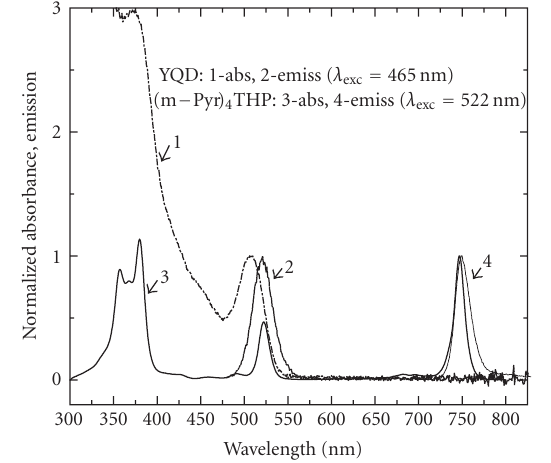
Figure 2: PL quenching of YQD by (m − Pyr) 4 H 2 P in toluene. Data are obtained for 3 di ff erent samples from the same YQD stock solu- tion after 9 months ( (cid:3) ) and after 14 months ( •